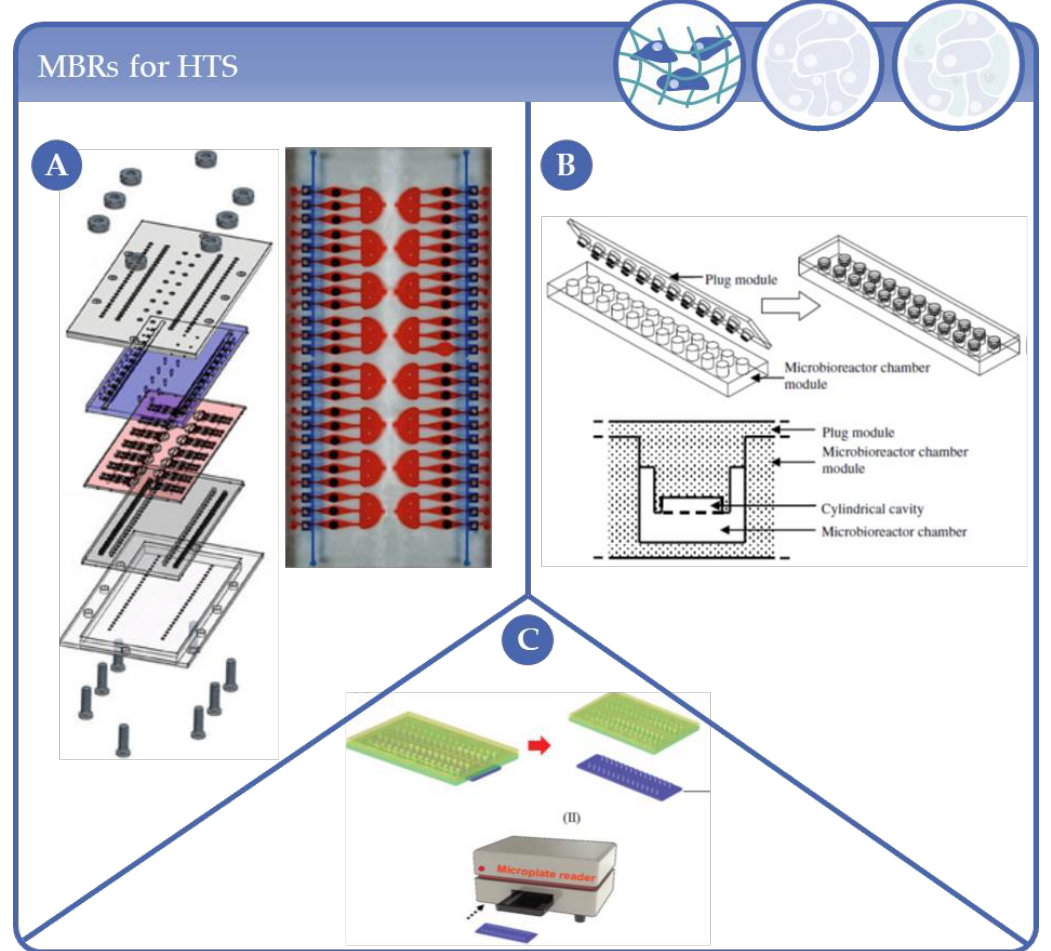
Figure 6. Advanced development of miniaturized MBRs for HTS applications. ( A ) MBR platform with 16 cell culture sections comprising three MBRs; reprinted from [31] with permission from Springer Nature. ( B ) MBR platform